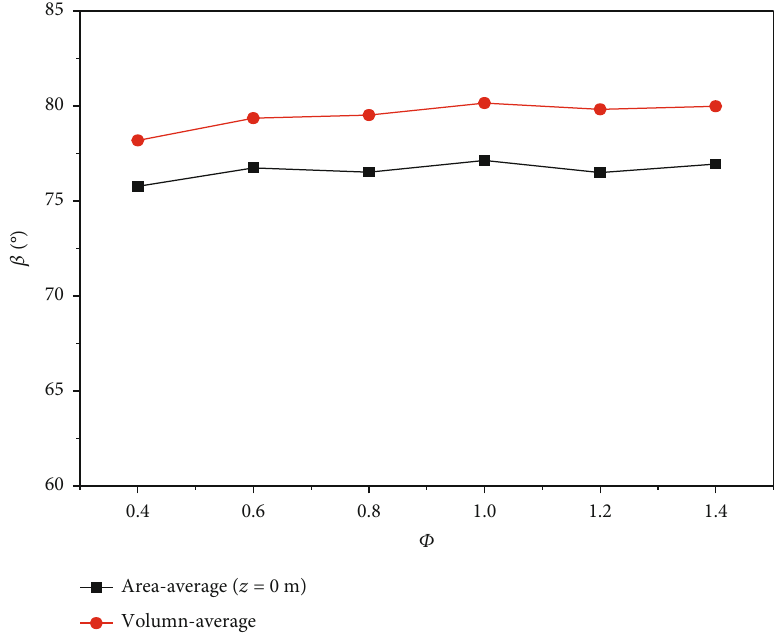
Figure 22: Volume average synergy angle and area average synergy angle distribution under di ff erent equivalent